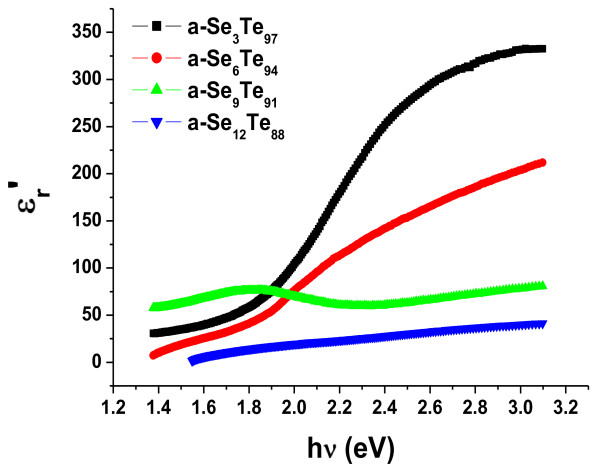
Variation of dielectric constant real part with incident photon energy in a-SexTe100-xaligned nanorod thin films. Єr′, real part of the dielectric constant; hν, incident photon energy.